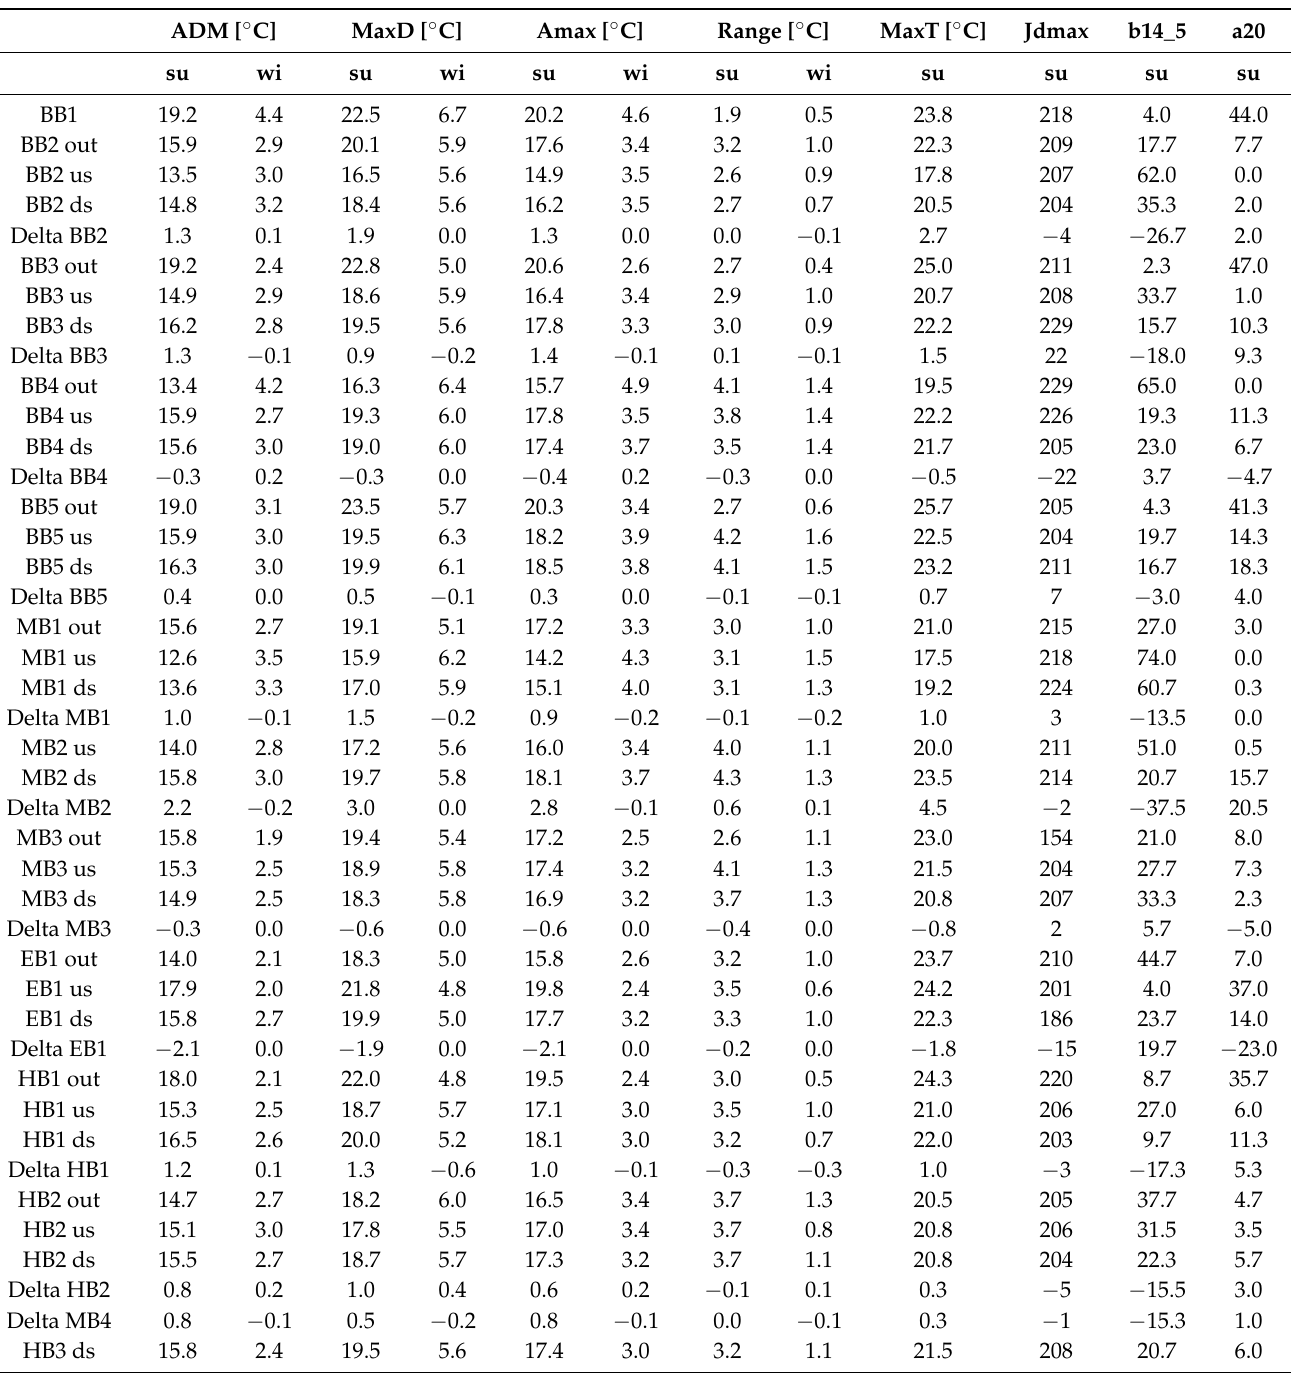
Table 5. Average temperature metrics (codes after Table 3, su = summer, wi = winter) at the three monitoring points per site, as well as the difference between the value calculated at ‘us’ compared to ‘ds’ (delta value) over the whole study